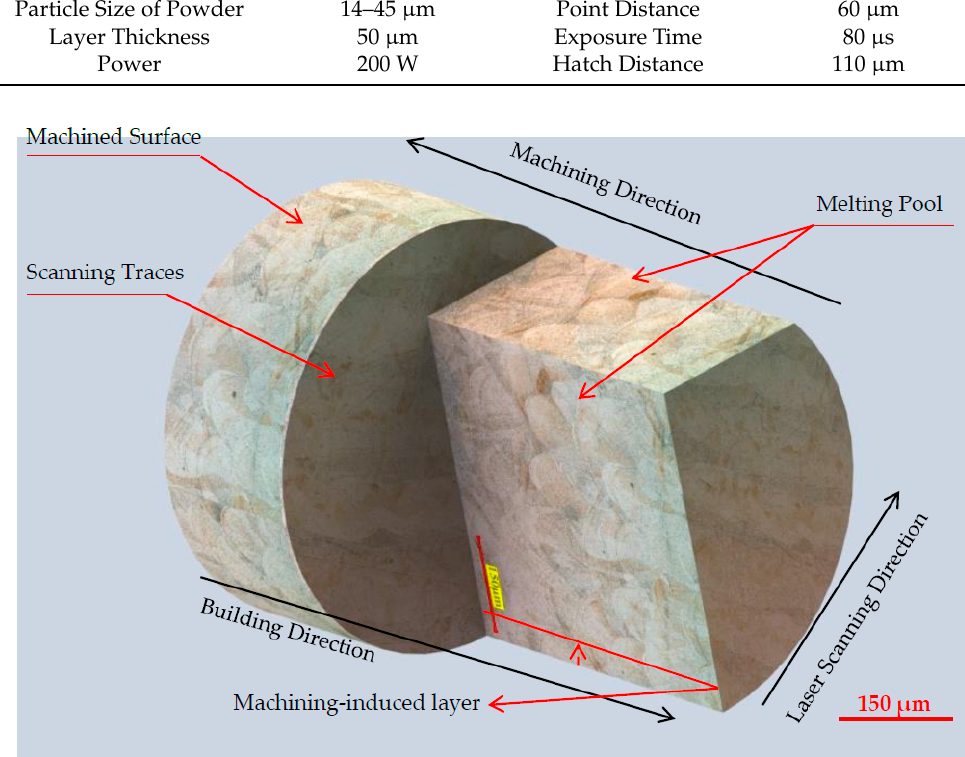
Figure 1. Microstructure and building directions of as-built SLMed 316L sample.